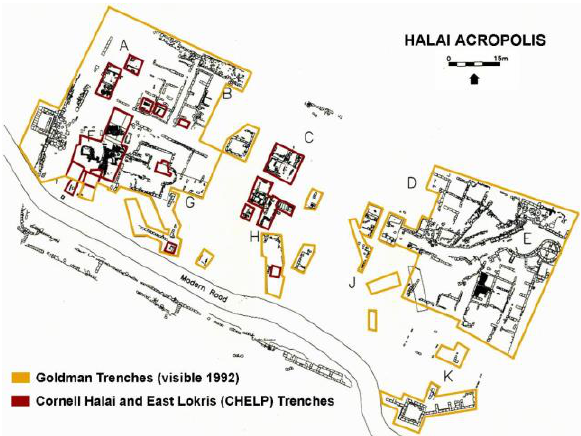
Figure 4. Plan of the H. Goldman Trenches & Cornell Halai and East Locris Trenches (CHELP) © J.